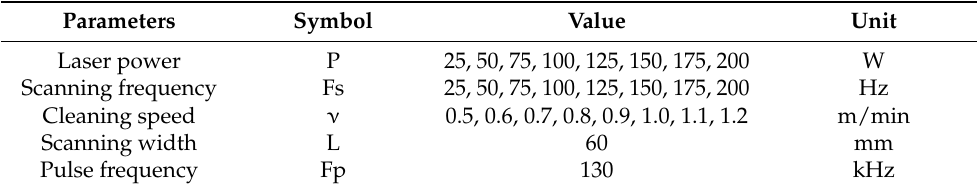
Table 1. Main parameters of laser cleaning.